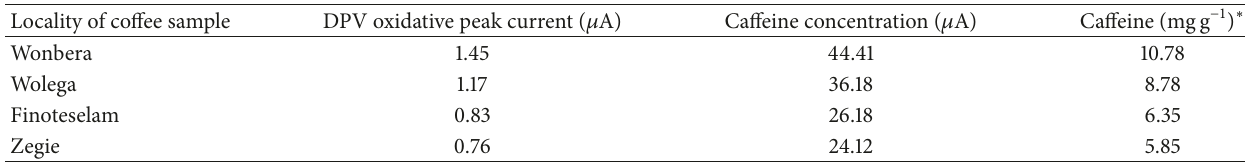
Table 1: Summary of concentration of caffeine in aqueous coffee extract and corresponding amount of caffeine per gram of roasted coffee of coffee samples from different localities of Ethiopia.